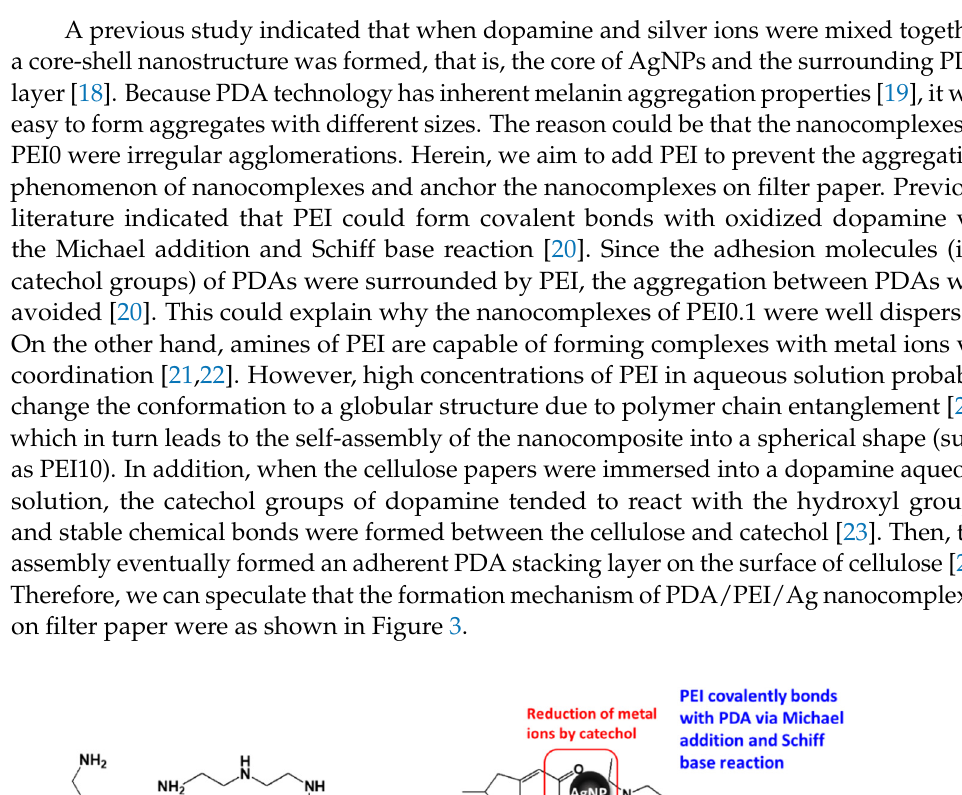
Figure 2. SEM views of the different nanocomplexes on filter papers.